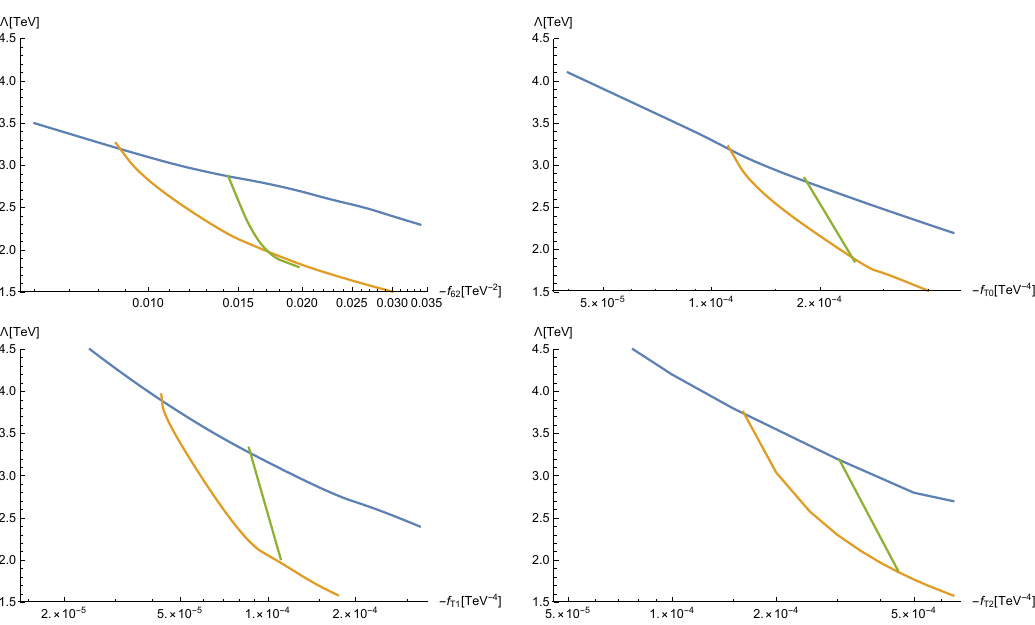
Figure 5 . Same description and operators as in (cid:12)gure 3. Negative values for c i and f i are